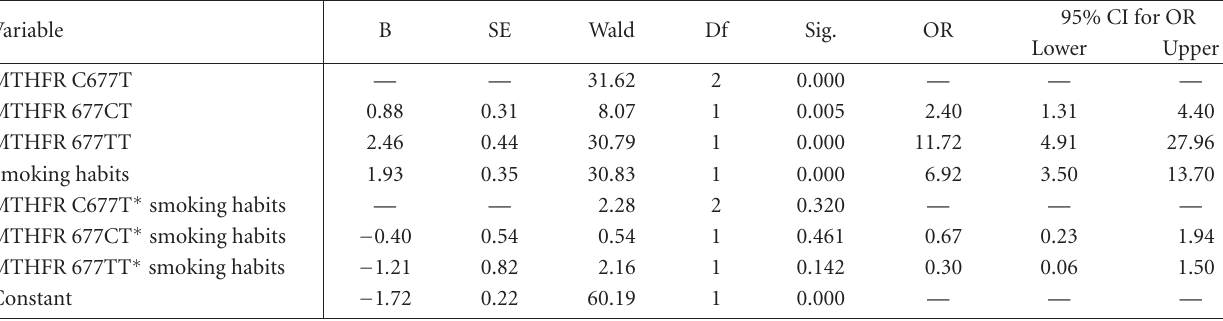
Table 3: Logistic regression model (with backward likelihood ratio method) built with HHcy as a dependent variable and all other risk factors as predictors variables. B: logistic regression coe ffi cient; SE: standard error; Df: degree of freedom; Sig.: significant level; OR: odds ratio; 95% CI: 95% confidence interval of the